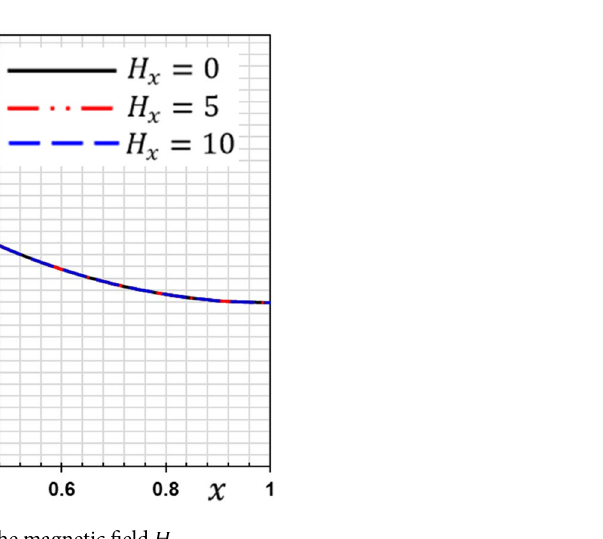
Figure 15. The temperature θ with the magnetic field H x